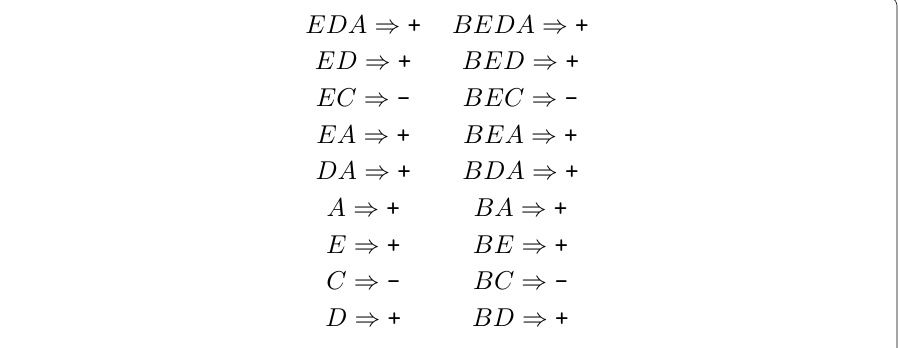
Fig. 2 An example model with CARs for the dataset in Table